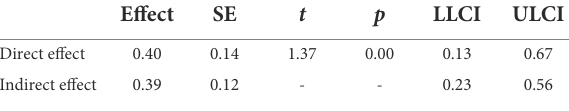
TABLE 3 Mediation effect of cognitive fluency (Study